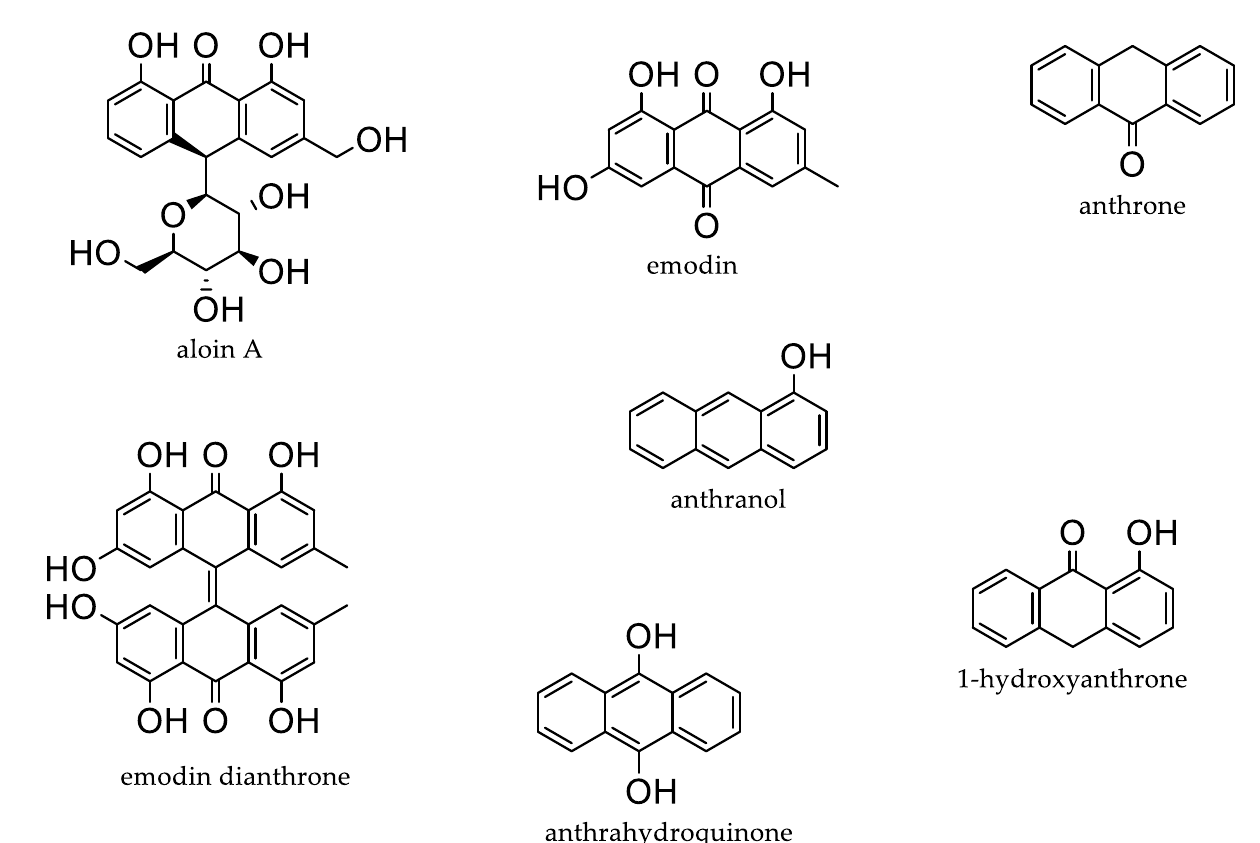
Figure 1. Examples of different anthraquinones.